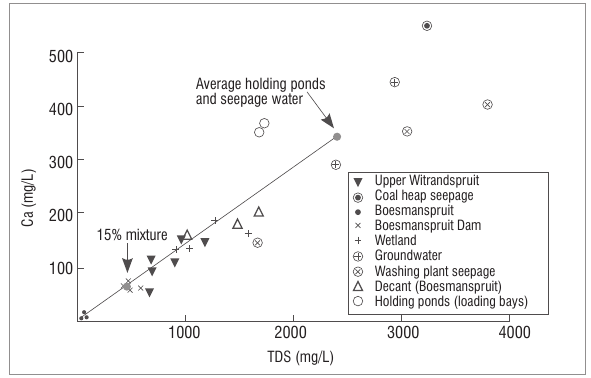
Figure 14: Binary plot of calcium (Ca) against total dissolved solids (TDS) showing the mixing line formed by mixing Boesmanspruit-type water with water having the average composition of holding ponds and seepages. A volume of polluted water equivalent to about 15% of the volume of the dam is required to cause the observed pollution level in the